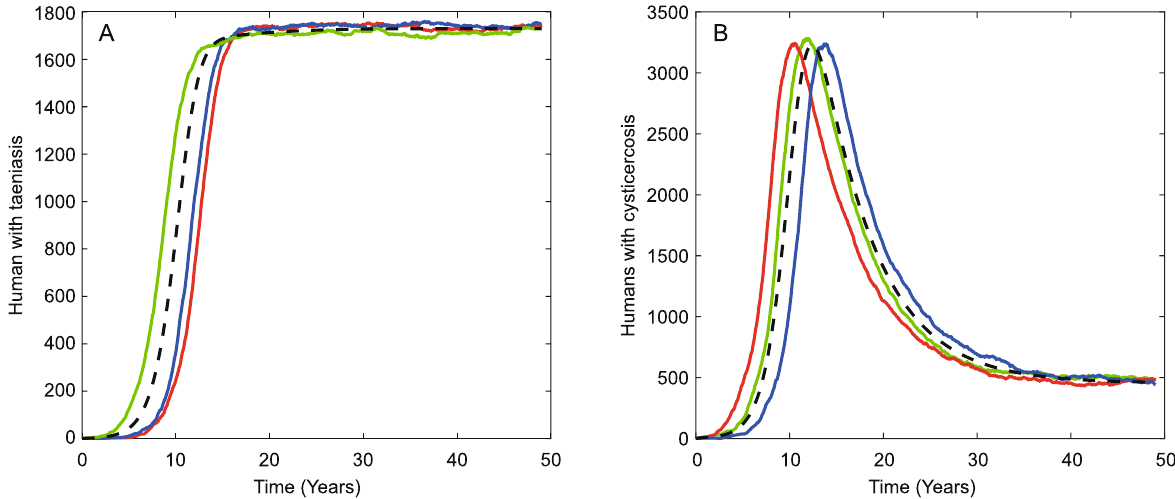
Fig. 5 Taeniasis and cysticercosis in human. A . Human with taeniasis; B . Human with